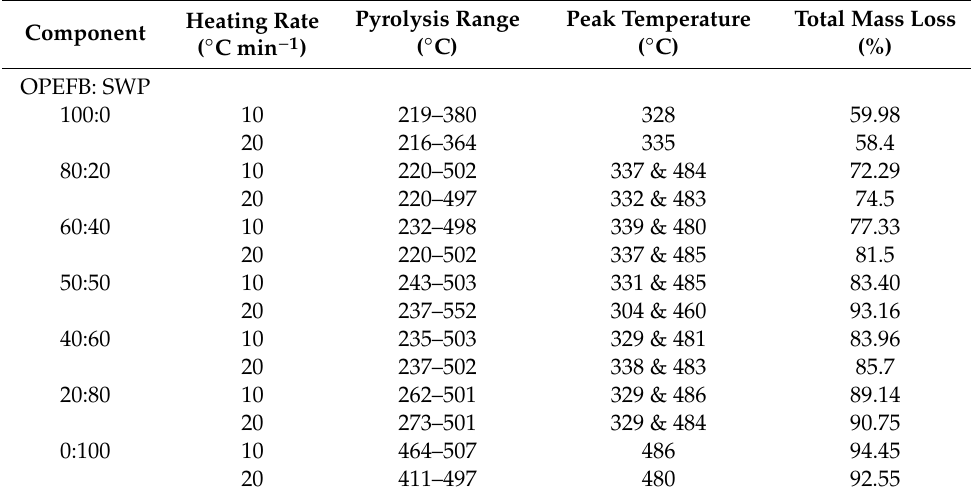
Table 2. Properties of active pyrolysis zone at di ff erent heating